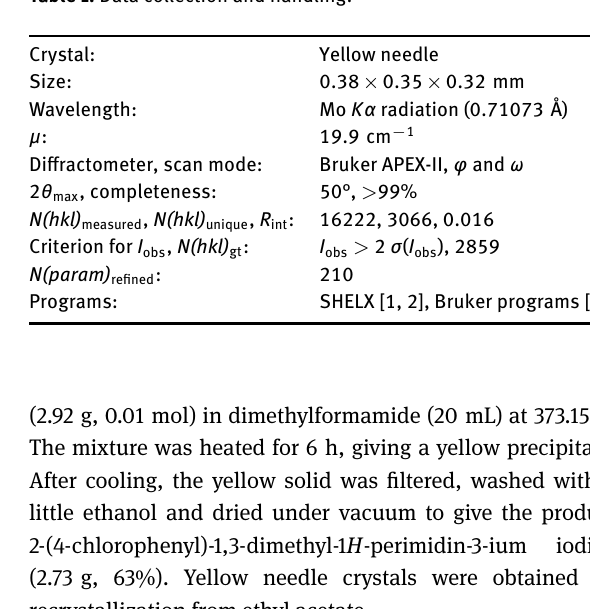
Table 1: Data collection and